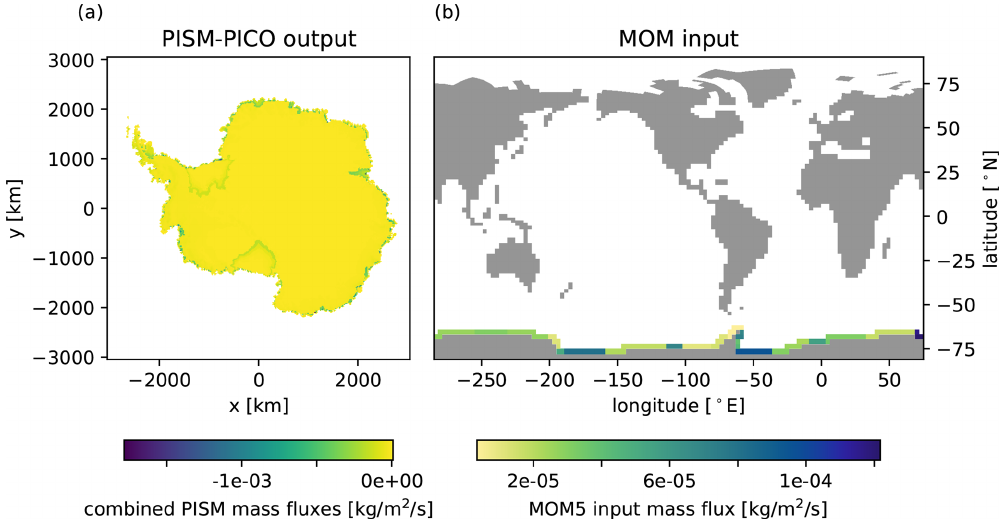
Figure 7. Visualization of (a) PISM mass flux distribution to (b) the MOM5 ocean grid. PISM output variables describing surface runoff, basal melting, and calving are aggregated over space and time (coupling time step) to calculate mass and energy fluxes which are processed as input to the MOM5 ocean component as described in Sect. 4.2. Panel (b) shows the corresponding mass flux distribution on the MOM5 grid.